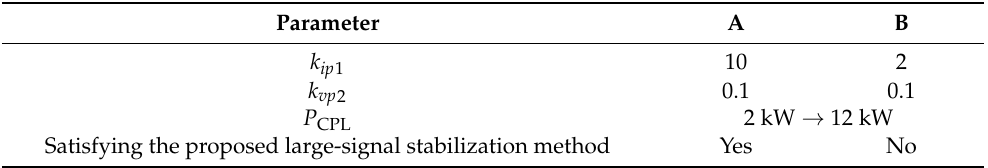
Table 2. Simulation parameters of A and B.